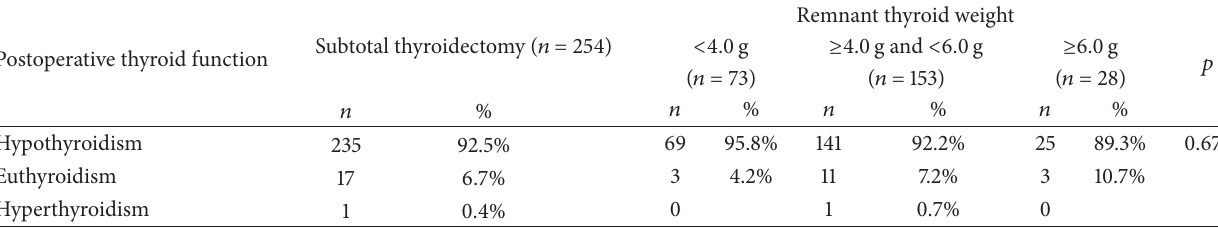
Table 2: Postoperative thyroid function after subtotal thyroidectomy at 3 months and thyroid function distribution by amount of remnant